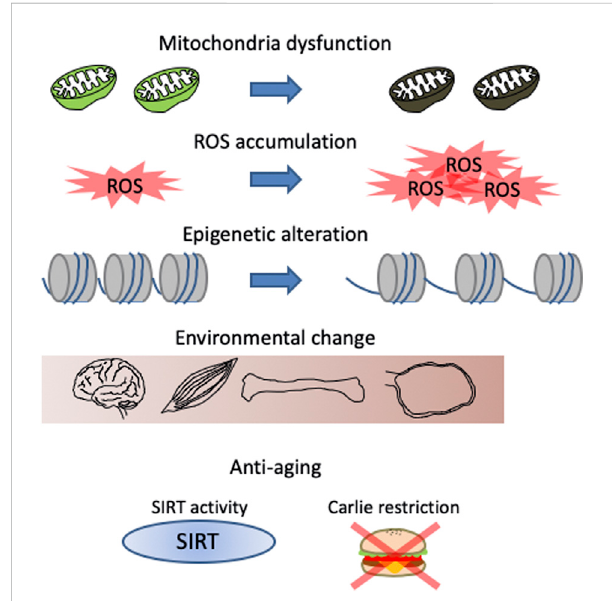
FIGURE 3 Features of aging phenotypes in both stem cells and oocytes in primordial follicles. Changes related to energy metabolism, such as mitochondrial dysfunction and reactive oxygen species (ROS) accumulation, changes in gene expression due to chromatin relaxation, and changes in the microenvironment such as fi brosis and changes secreted cytokines are known. Sirtuin (SIRT) activation and calorie restriction are known methods to delay these